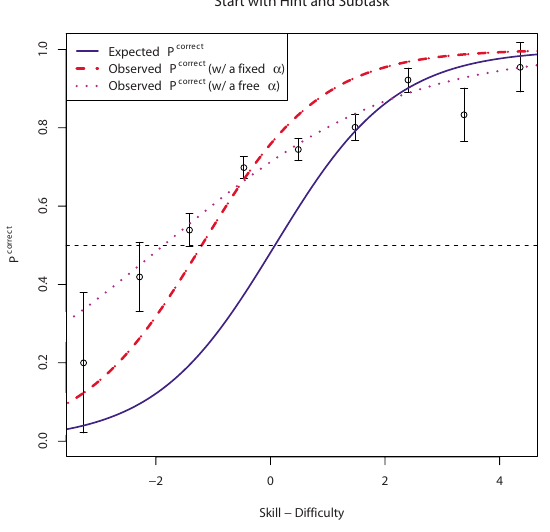
FIG. 5. (cid:1) Color (cid:2) Logistic fits to the first attempt of students used hint and/or subtask before their first